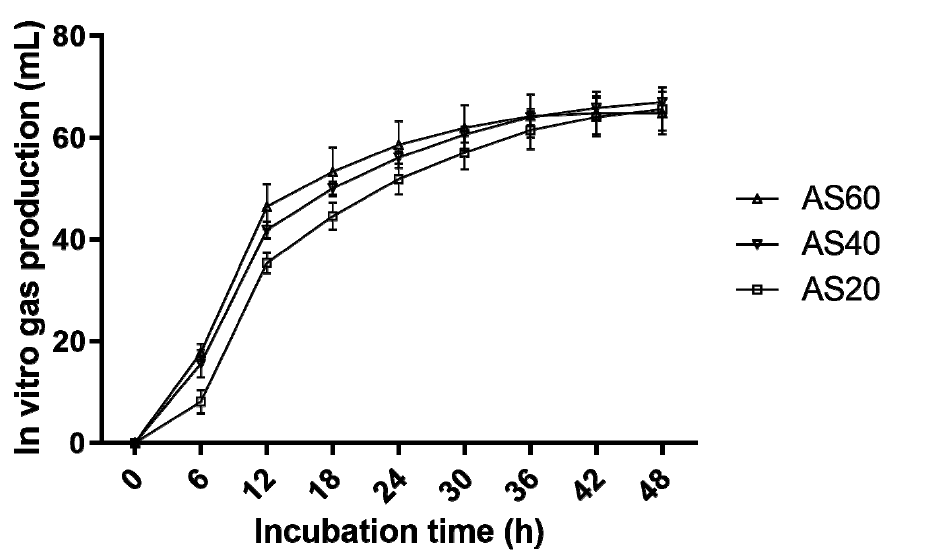
Figure 1. Gas production (mL) profiles from in vitro fermentation of the TMR silage for 48 h (bars indicate the standard errors of the means). AS60, TMR containing 60% alfalfa silage (DM); AS40, TMR containing 40% alfalfa silage (DM); AS20, TMR containing 20% alfalfa silage (DM).